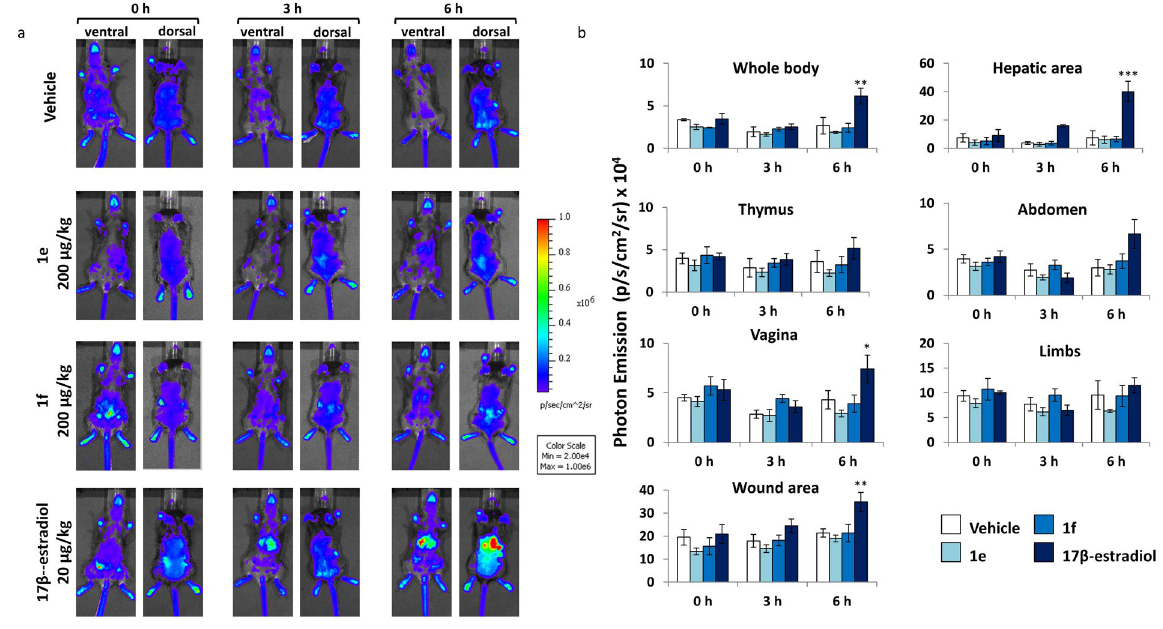
Figure 5. Time-course analysis of ER activity in selected body areas after administration of synthetic and natural estrogens. ( a ) Optical imaging of ERE- Luc mice at 0, 3 and 6 hours after the s.c. injection of the indicated compounds. Photos portray whole body (ventral and dorsal view) pseudocolor images representing the amount of photon emission. Each individual is representative of its own group. ( b ) In vivo BLI: photon emission from selected body areas were measured. Bars represent the mean + / − SEM of photon emission measured in 4 animals/group. * p < 0.05; ** p < 0.01; *** p < 0.001 vs time 0 ANOVA followed by Bonferroni’s test for multiple comparisons.